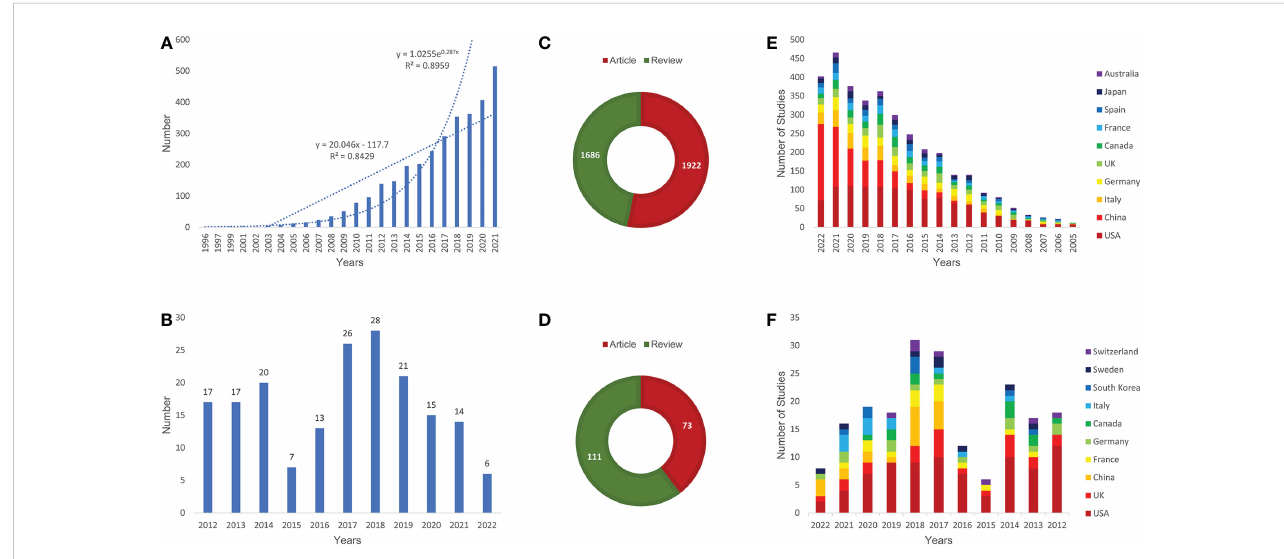
FIGURE 1 Annual number of publications (A, B) , the type of literature (C, D) , and the number of publications per year in common countries (E, F) of relevant literature. ( A, C, E : all relevant literature; B, D, F : citation